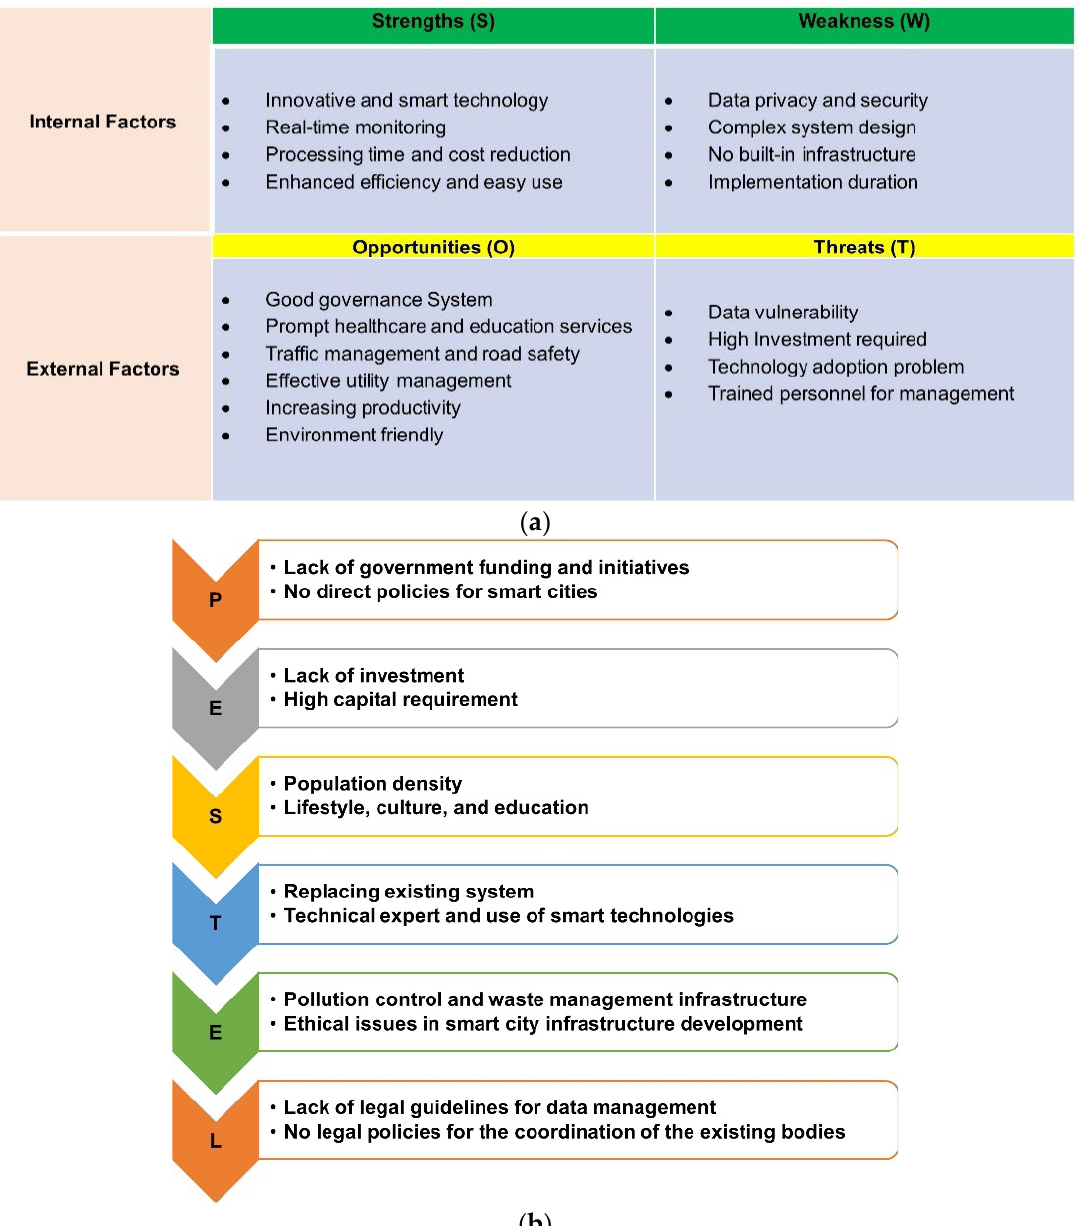
Figure 3. ( a ): SWOT analysis for existing smart cities. ( b ): PESTEL analysis for Dhaka, Bangladesh.